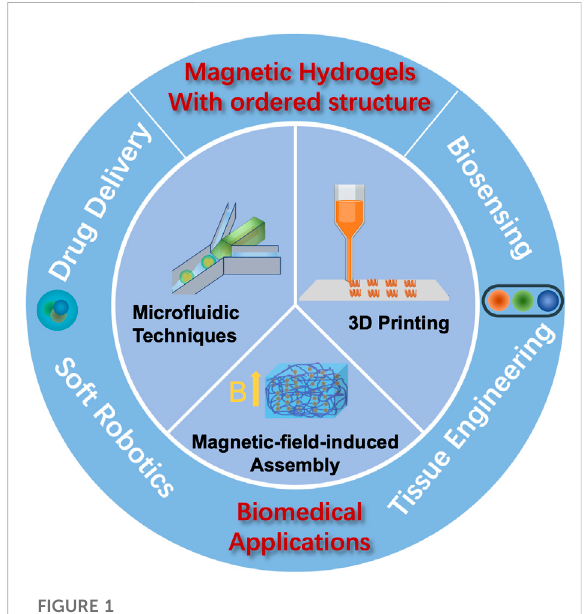
FIGURE 1 Schematic illustration of the fabrication of magnetic hydrogels with ordered structure and their biomedical